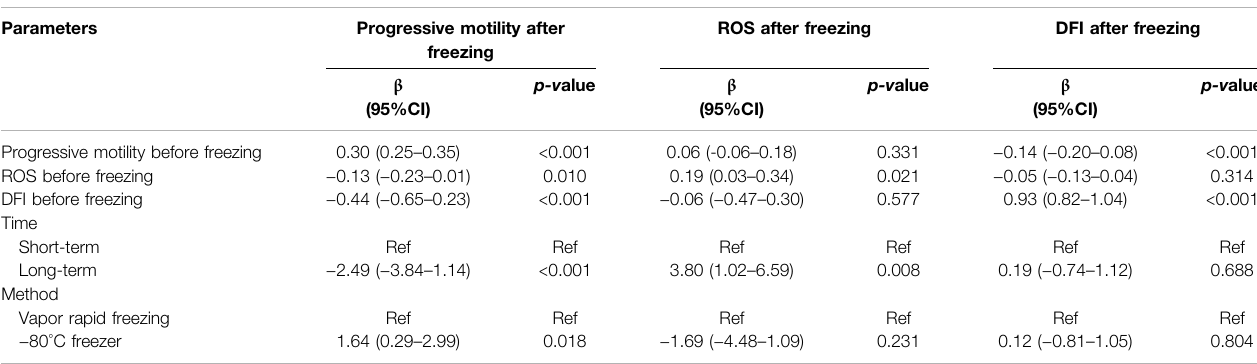
TABLE 4 | Results from the regression analyses after freezing sperm